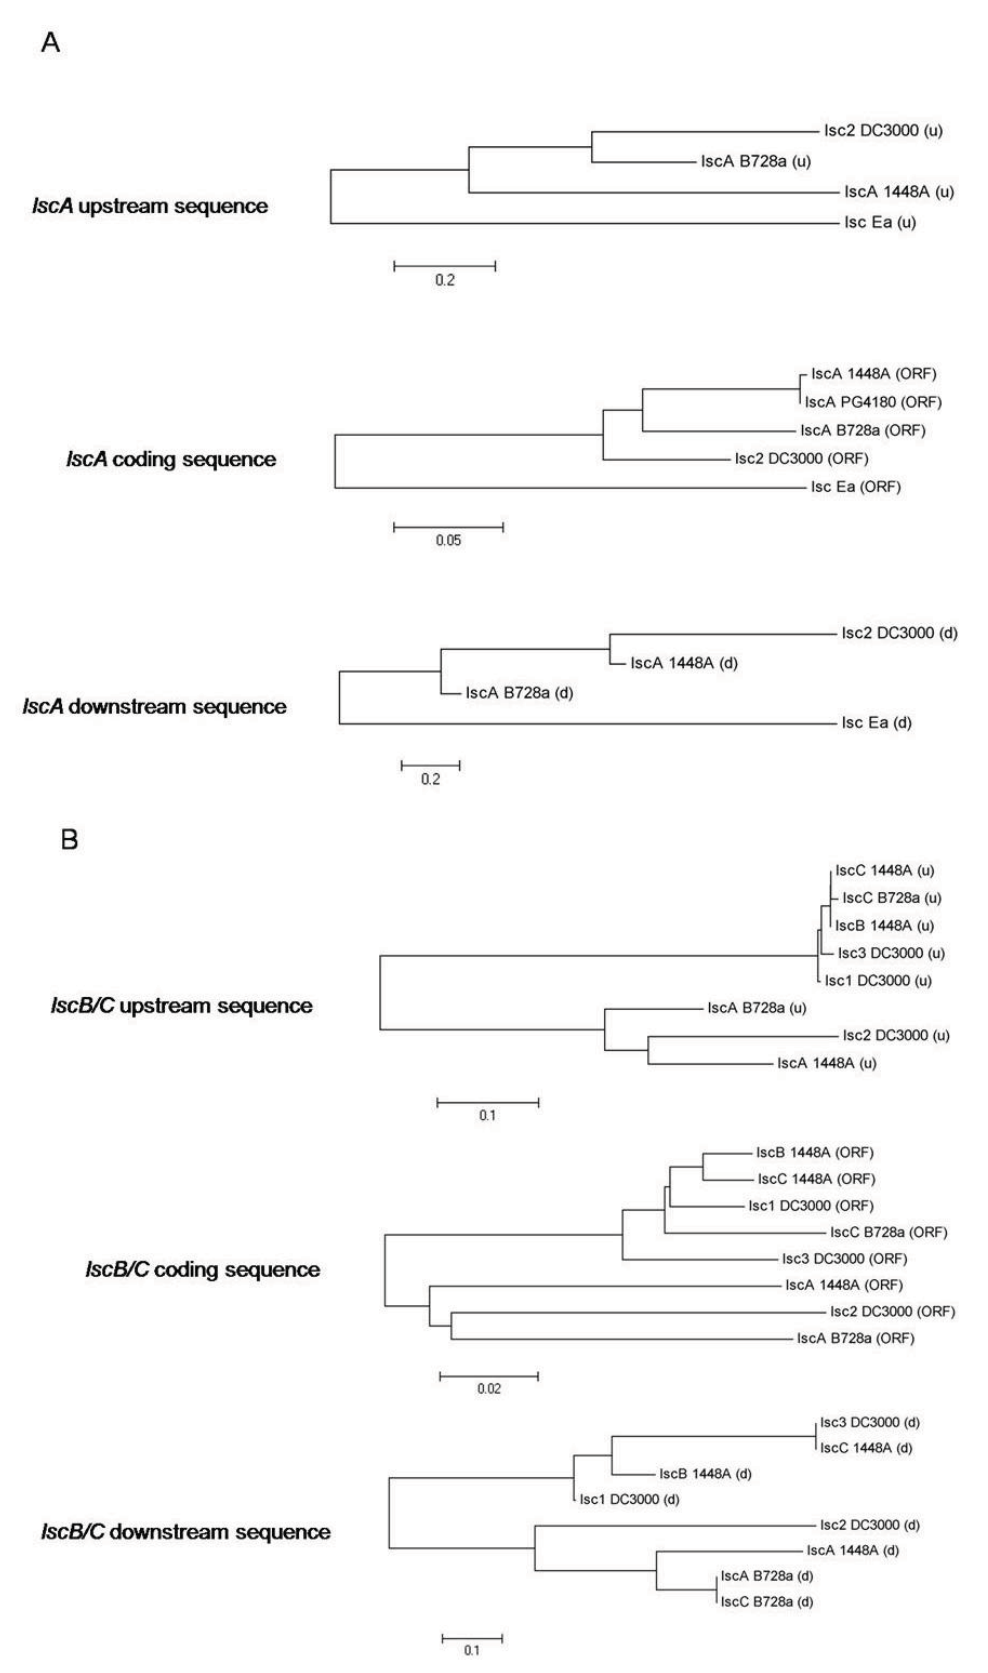
Figure A2. Phylogenetic dendrograms of variant BC lsc genes and their up- and downstream